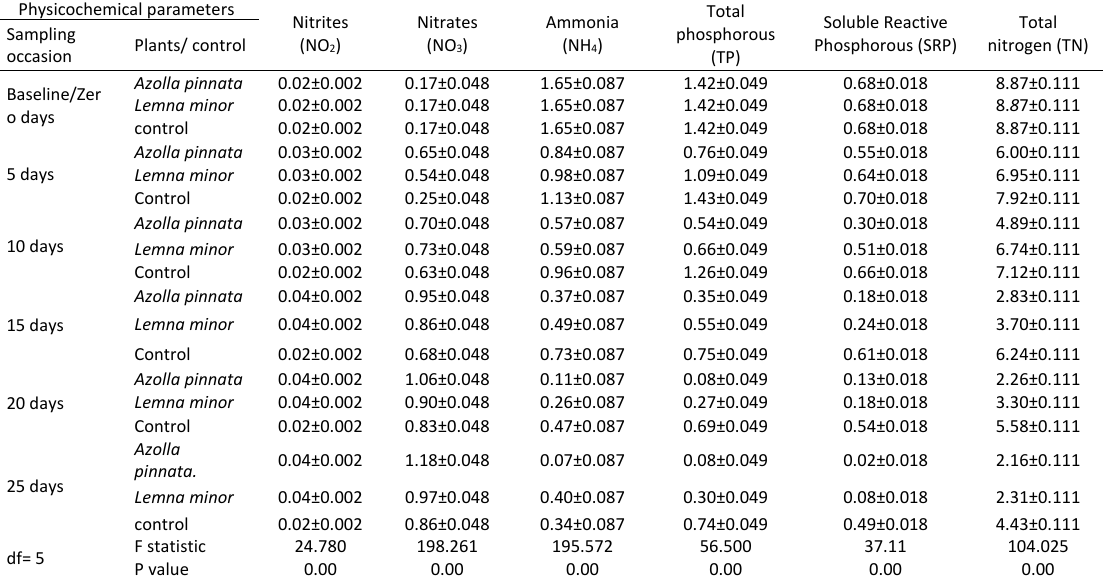
Table 3: Showing nutrients concentrations (means ±SE) in wastewater in different sampling occasions Physicochemical